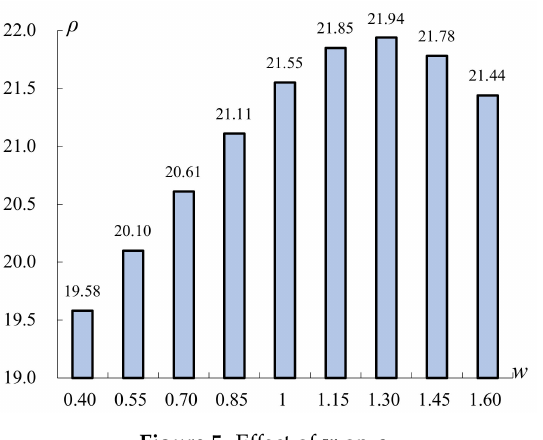
Figure 5. E ff ect of w on ρ .